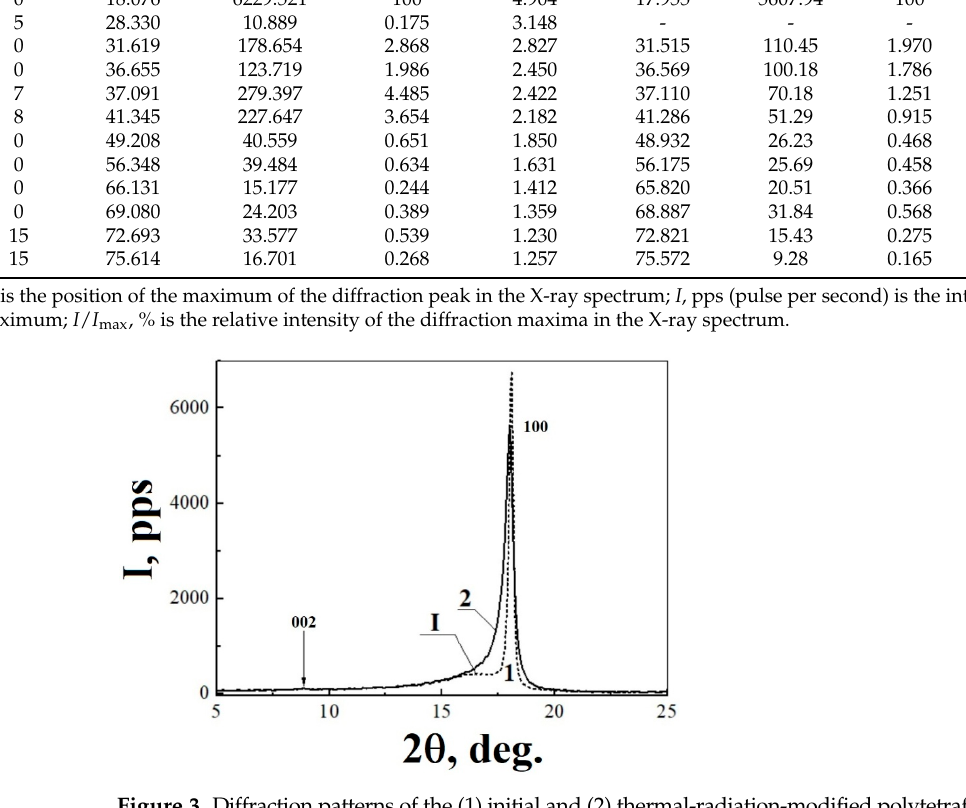
Figure 3. Diffraction patterns of the (1) initial and (2) thermal-radiation-modified polytetrafluoroethylene samples in the range of diffraction angles 2 θ = 5°–25°: (I) is the diffuse diffraction maximum at 2 θ = 10°–25° and 002 and 100 are the meridional and equatorial reflections of polytetrafluoroethylene, respectively. Table 1. Characteristics of the X-ray scattering spectra of the initial and thermal-radiation-modified polytetrafluoroeth- ylene samples. Miller Indexes